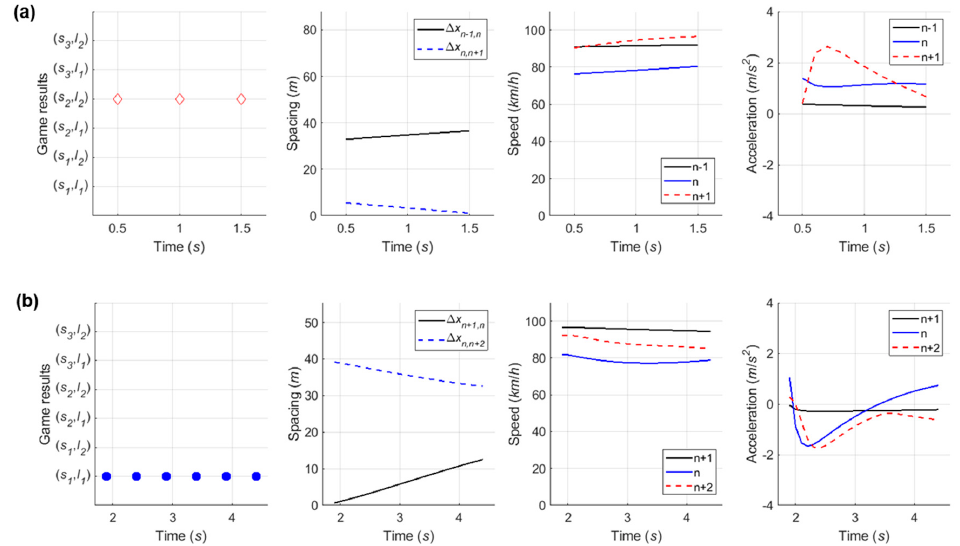
Figure 26. Decision-making game results in case 5 using the repeated game model: ( a ) Initial game with n + 1; ( b ) additional game with n + 2.